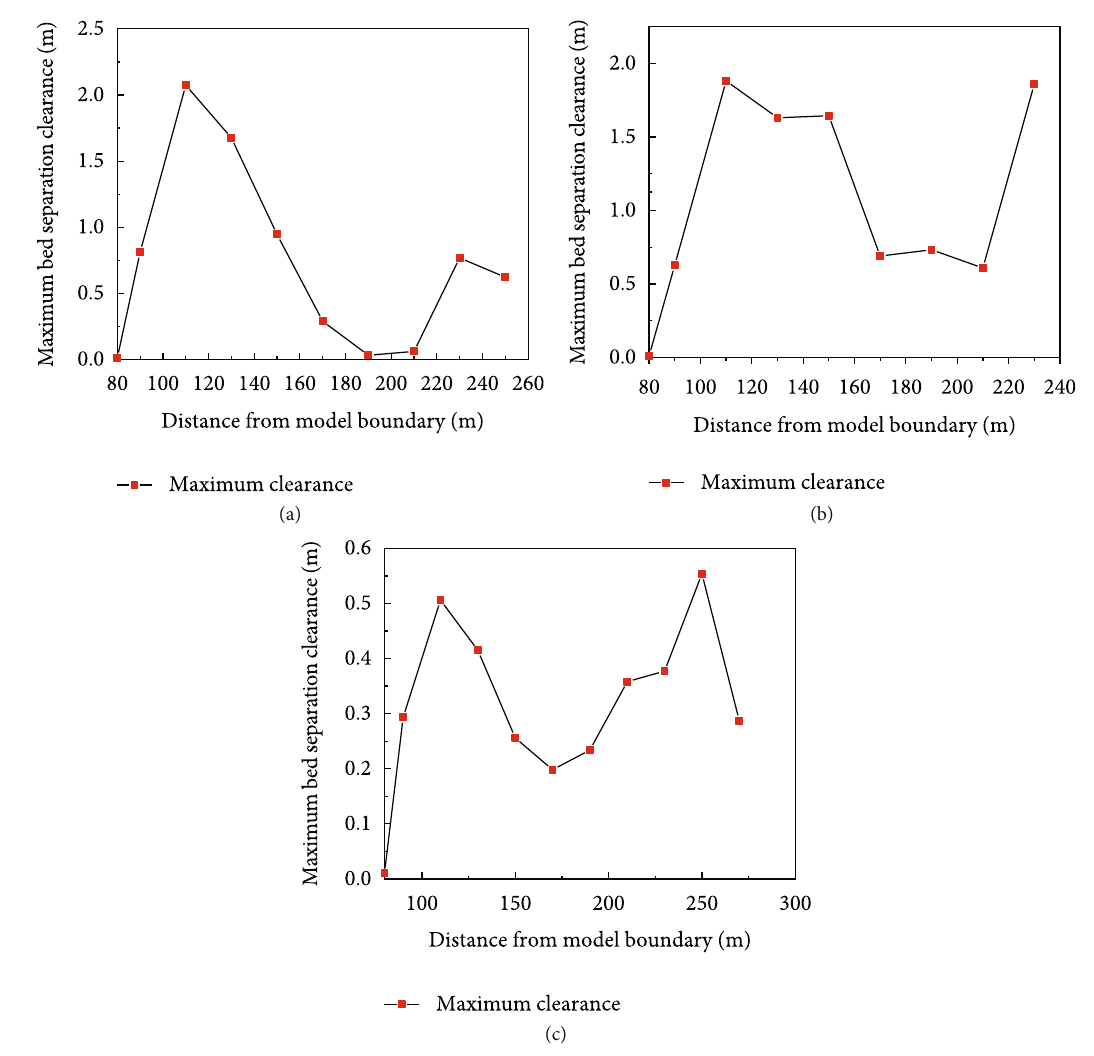
Figure 10: Maximum clearance of bed separation ((a) – (c) are the maximum clearance when mining coal 1, coal 2, and coal 3,